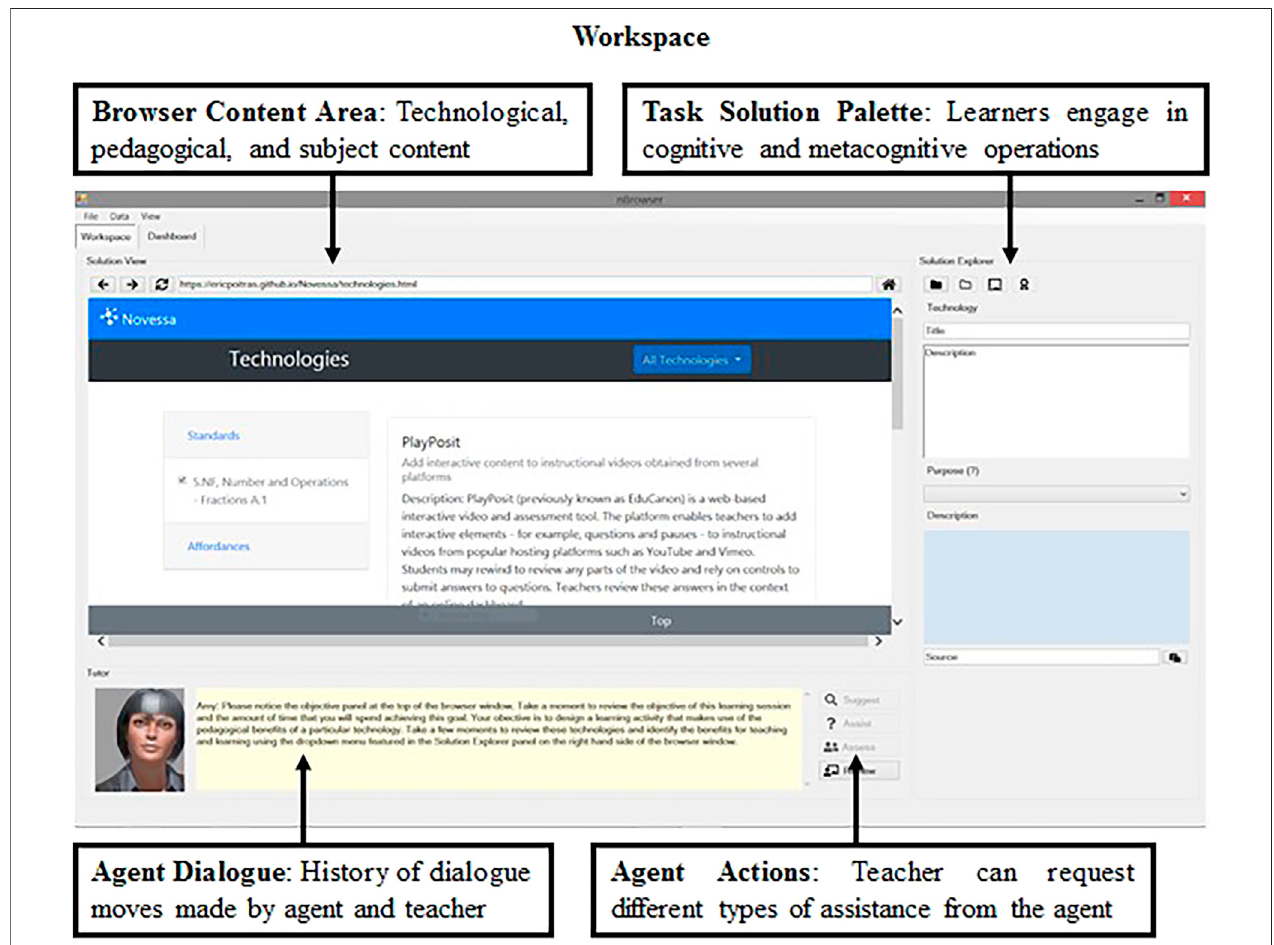
FIGURE 1 | The nBrowser